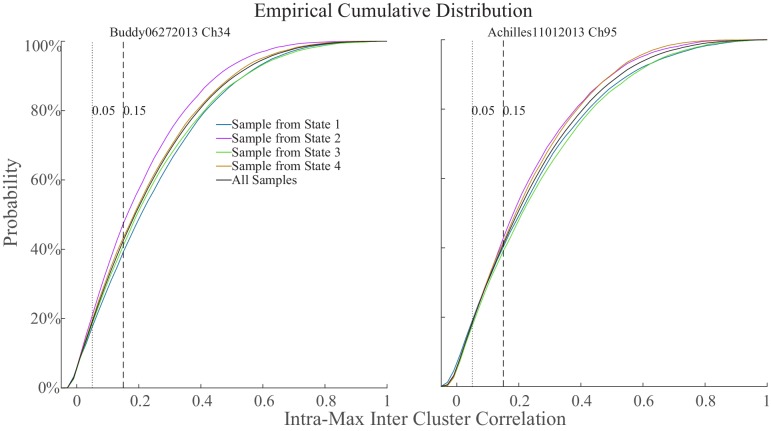
Intra-cluster sample correlation versus inter-cluster sample correlation.Example distributions of the difference between intra- and the maximum inter-cluster correlation in two different animals.